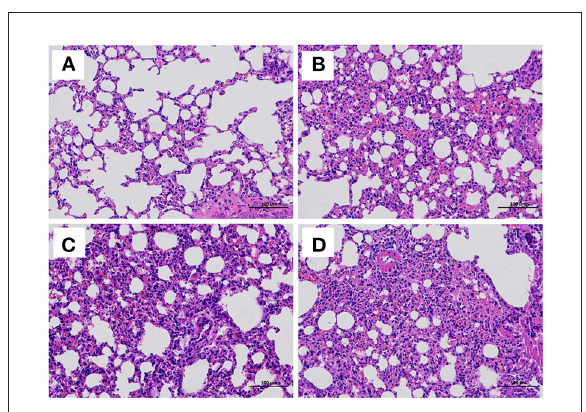
FIGURE6 Histological examination of the lungs of mice in different groups at 14 days post-challenge. Mice in different groups were challenged with PRV at 28 dpi, and all surviving mice were euthanized and necropsied. The lungs were collected for histological examination. PRV vaccine/AST group (A) , PRV vaccine group (B) , PRV/AST (C) , PRV group (D)